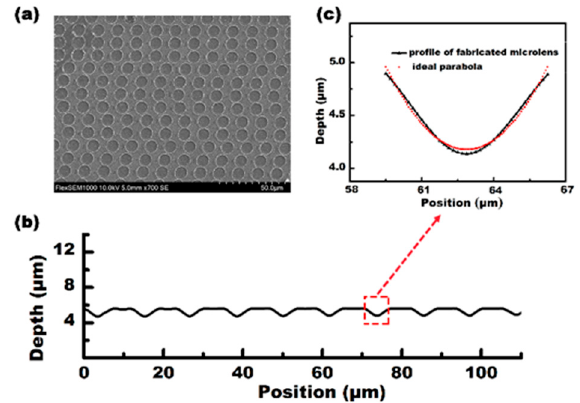
Figure 2. The characterization of the quasi-periodic microlens array (MLA) on a ZnSe surface. ( a ) A top-view scanning electron microscopy (SEM) image of the MLAs; ( b ) the actual profile of the microlens (line) and the ideal parabolic profile (dots); ( c ) A cross-section profile of the MLA that is shown in ( a ).